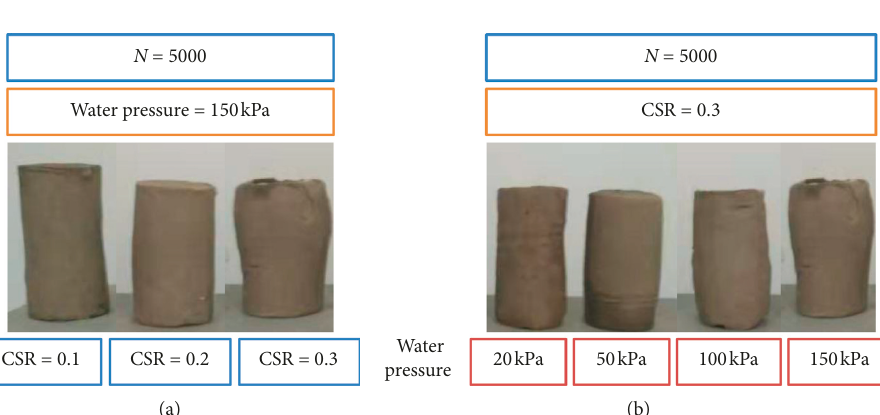
Figure 12: Failure mode of samples: (a) different CSRs; (b) different water pressures.